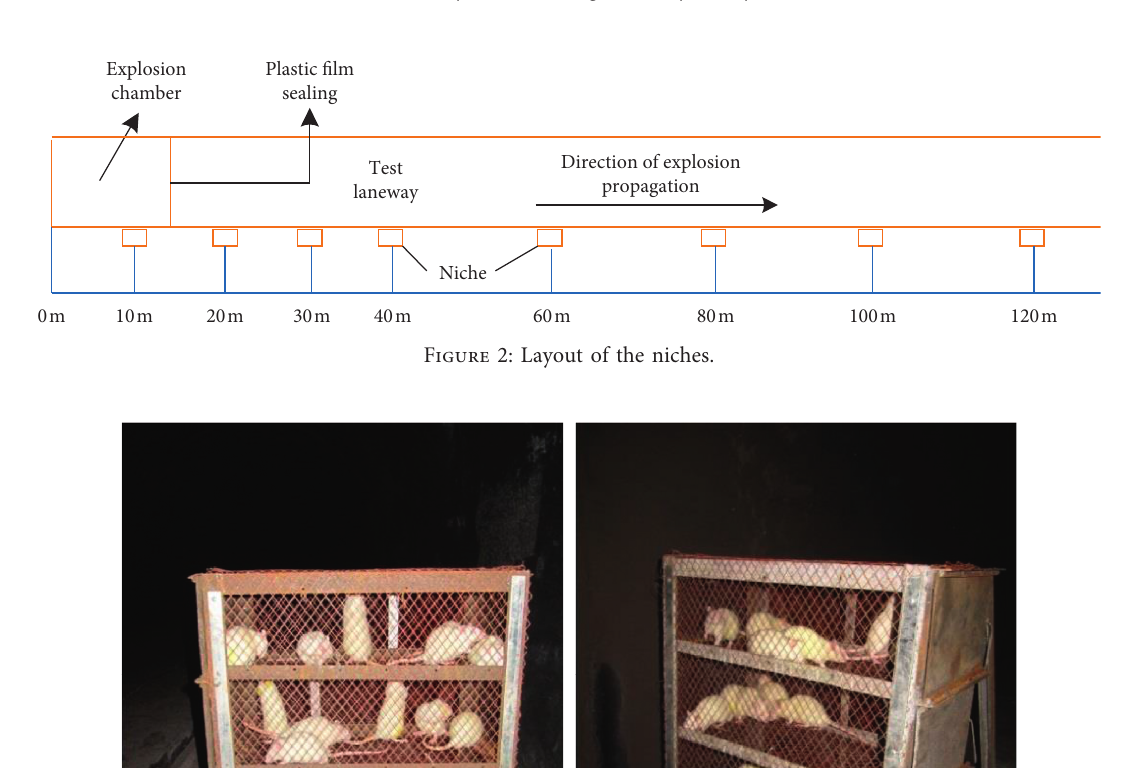
Figure 1: Layout of the large laneway test